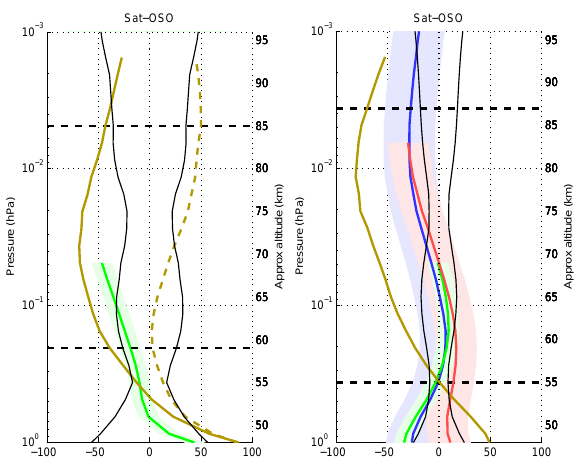
Fig. 13. The mean standard deviation between OSO and the satellites; absolute(left) and relative(right). MIPAS (12+13), SMR (v021), and the dotted SMR (v225) are from the time period 2002– 2004. The vertical coverage of the satellites explains the deviating extension of the profiles. The horizontal black dashed lines show the vertical limits of the OSO observations. The dashed line at 60km is the lower limit 2002–2004 and the dash-dotted line at 55km is the lower limit 2004–2008. The black line is the root-sum of the aver- age retrieval noise and the total forward model parameter variability of the OSO instrument. The summer values are